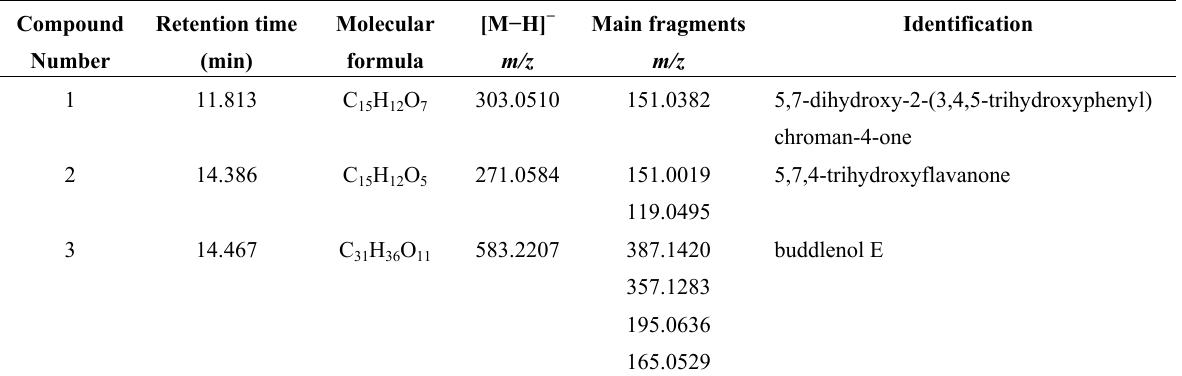
Table 2. Identification of the compounds in the extract by LC-ESI-MS/MS.